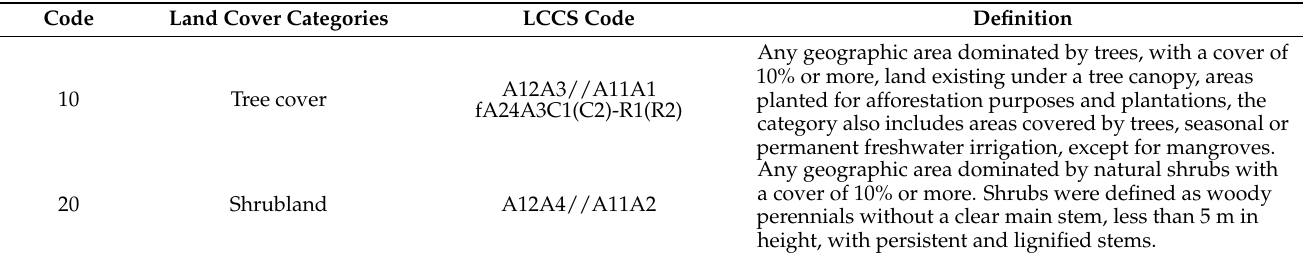
Table A1. Land cover categories in the study